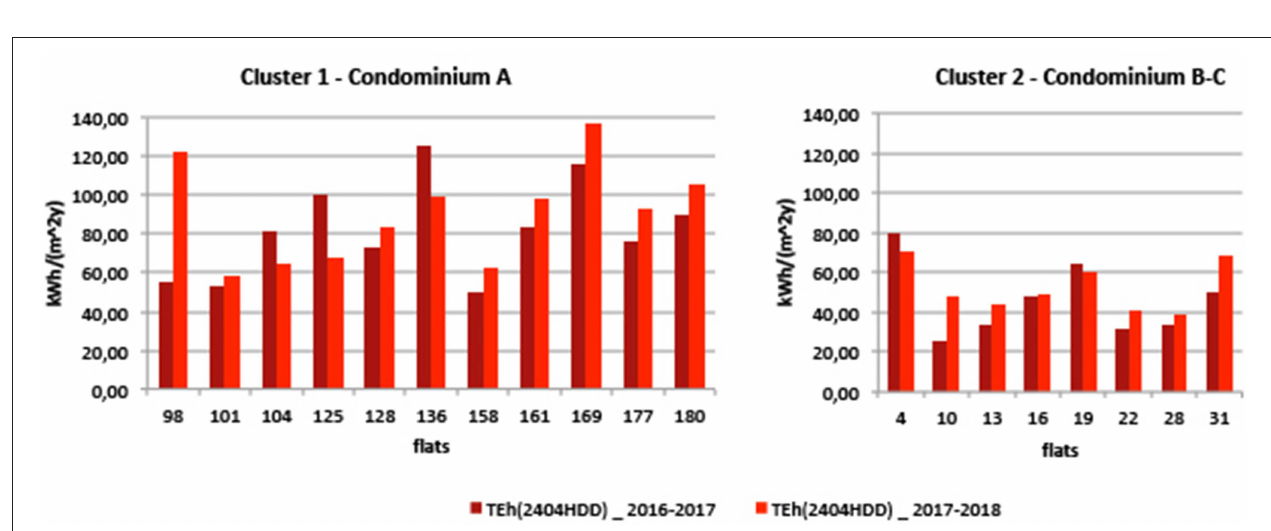
FIGURE 5 | Correlation of the actual thermal energy consumption for heating in the period 2017–2018 with possible influencing factors: floor area (A) , heating degree days (HDD) specific for each flat in the analyzed period (B) , floor where the flat is located (C) , and number of occupants (D) .